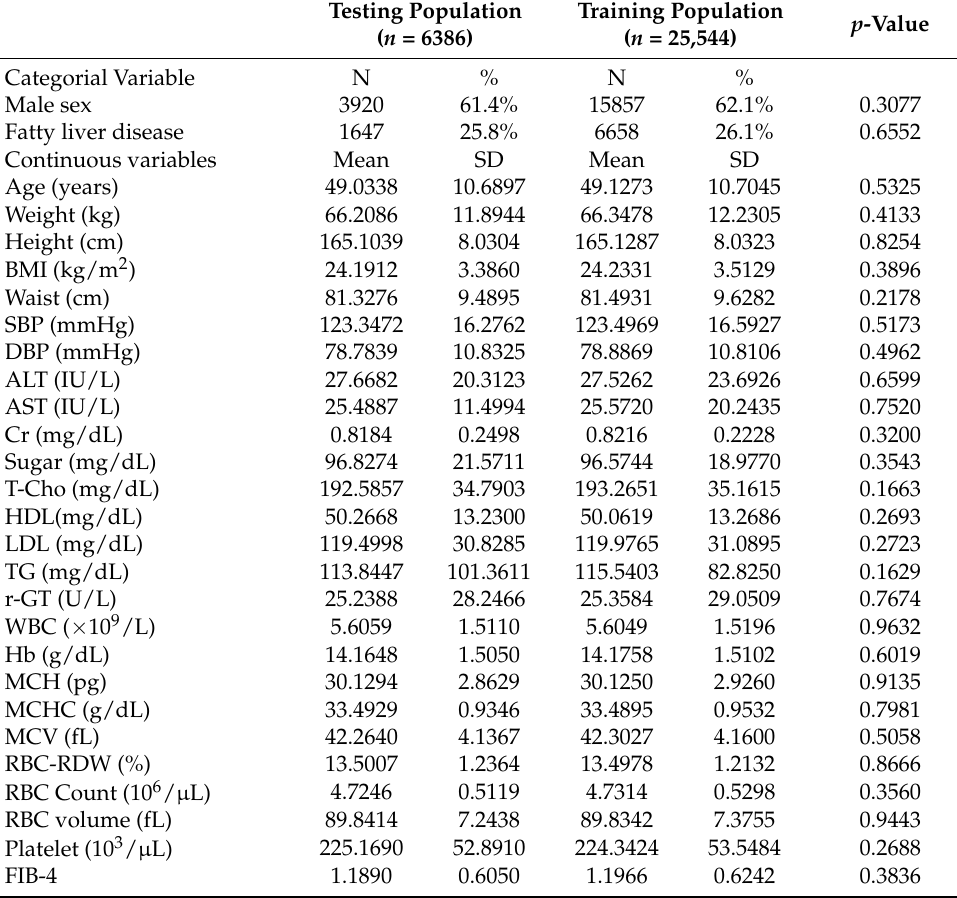
Table 2. Baseline data of the testing and training population .